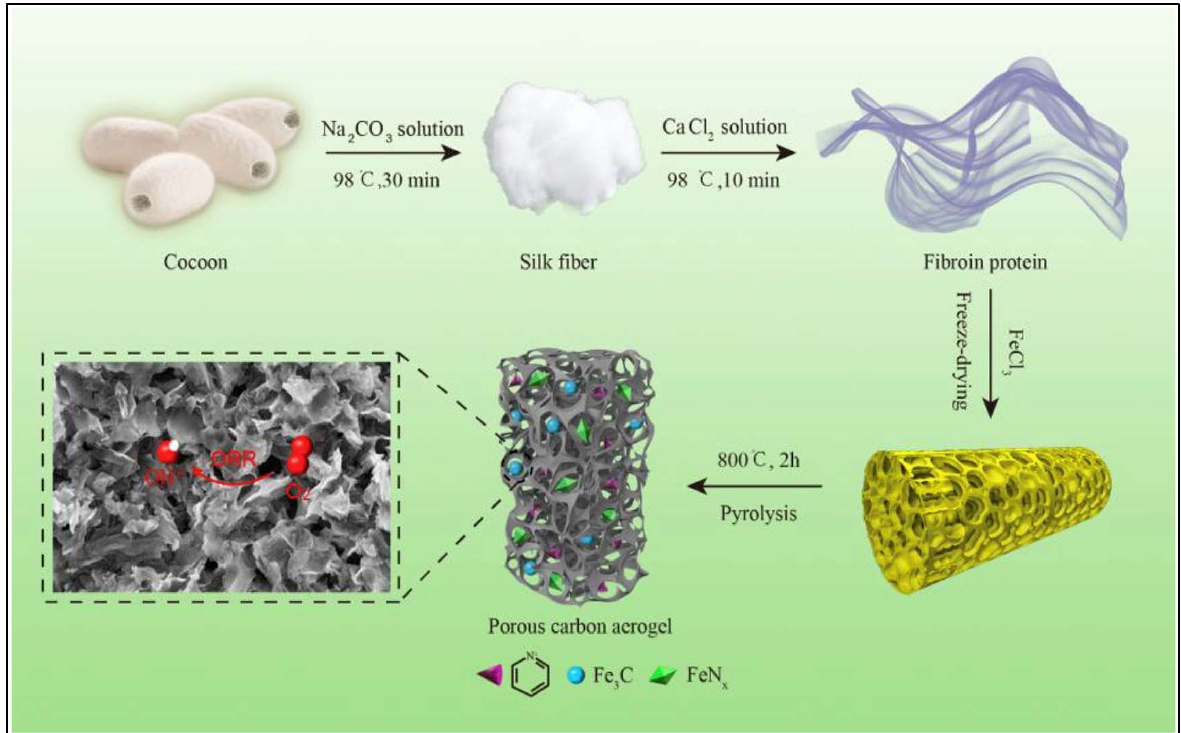
Figure 2. Schematic representation of agricultural carbon aerogel fabrication using cocoon as precursor material. Adapted from ref. [73] .